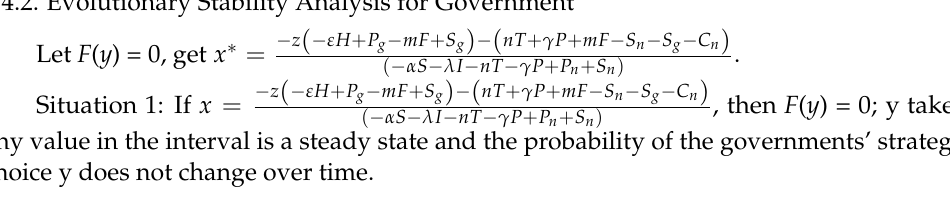
Figure 5. Dynamic evolution of new energy enterprise decision-making.